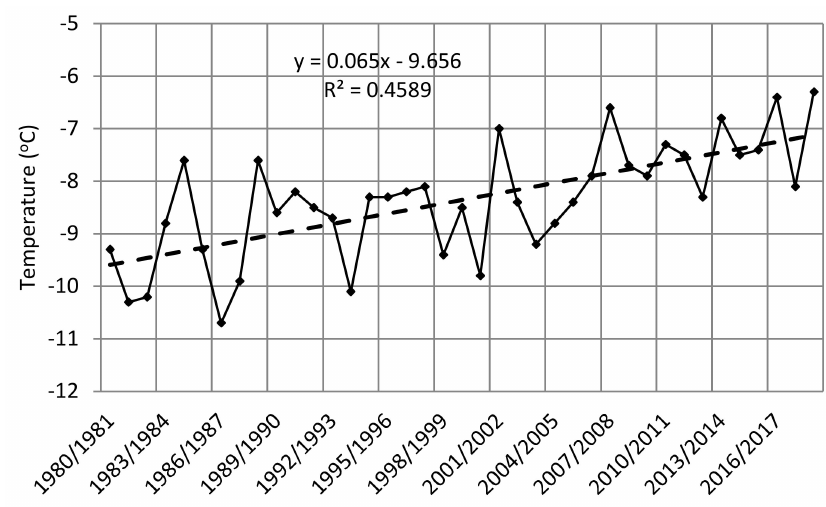
Figure 2. Long-term variability (1980–2019) of the mean annual air temperature in Yakutsk ( ◦ C). The linear trend is shown by the dotted line.